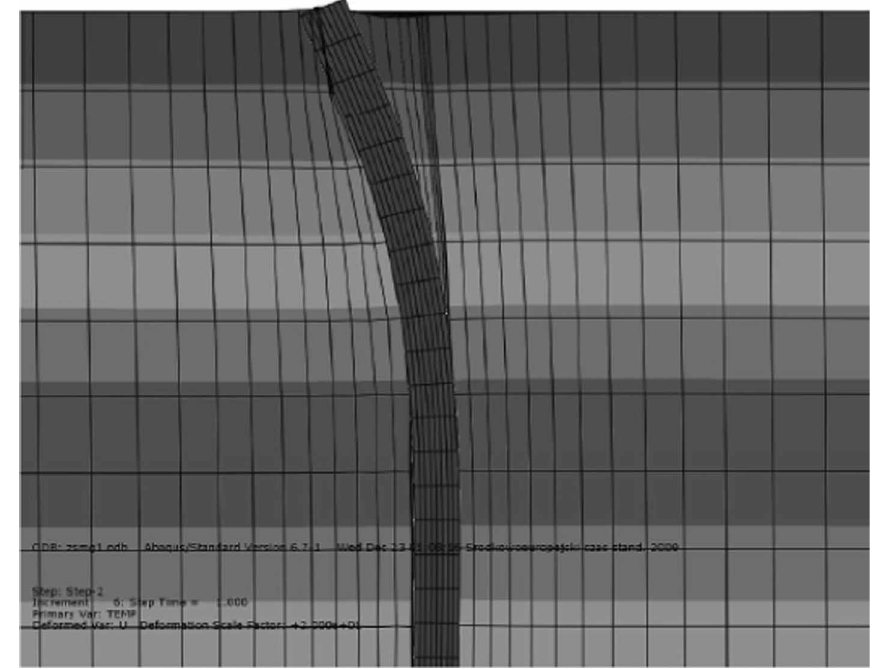
Fig. 4. An example of a displacement